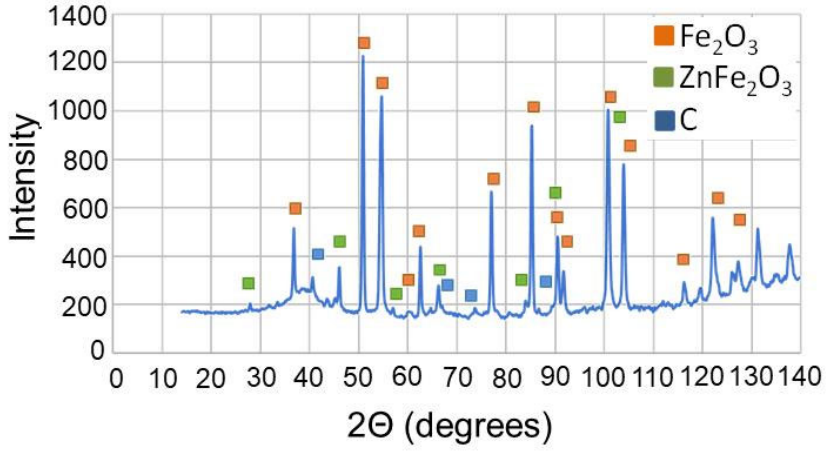
Figure 5. Diffractogram of blast-furnace sludge.